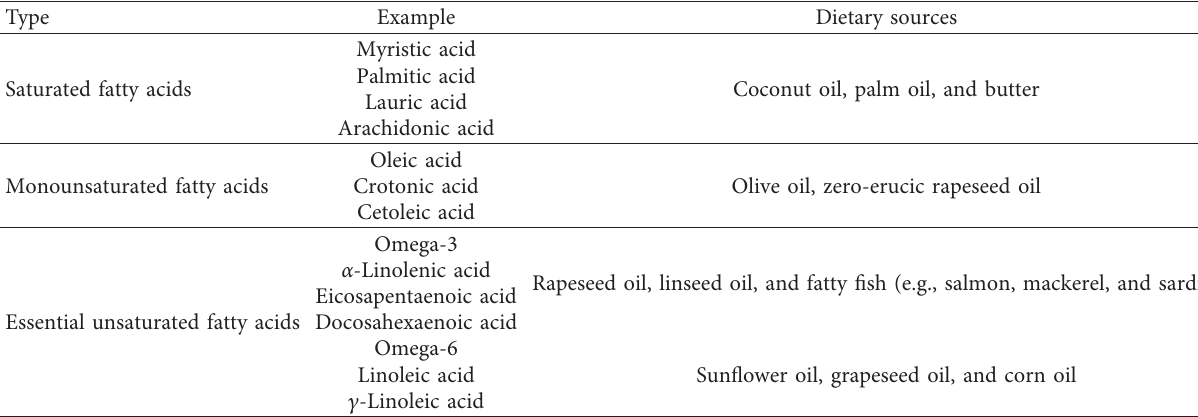
Table 2: Distribution of fatty acids and their dietary sources [17].